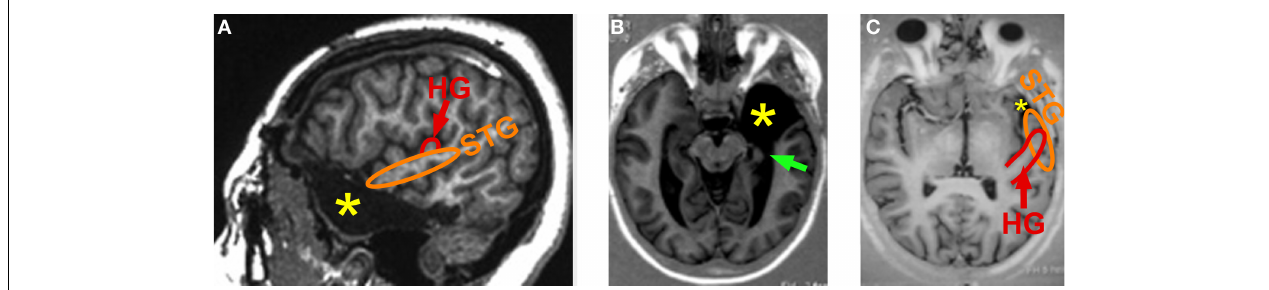
FIGURE 1 | Unilateral anterior temporal lobectomy: usual extent of resection. Post-operative MRI scans: ( A ) para-sagittal slice; ( B ) horizontal slice through the temporo-mesial structures; and (C) horizontal slice through the superior temporal gyrus (most superior aspect of the anterior temporal polectomy). The removal of